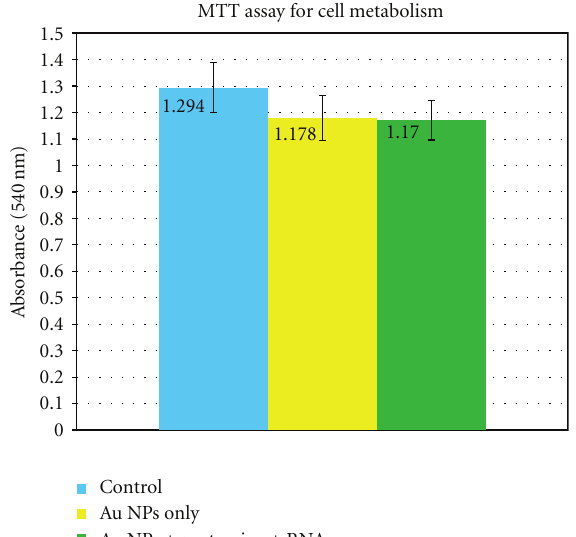
Figure 10: Evidence of continued cellular metabolic activity after incubation with